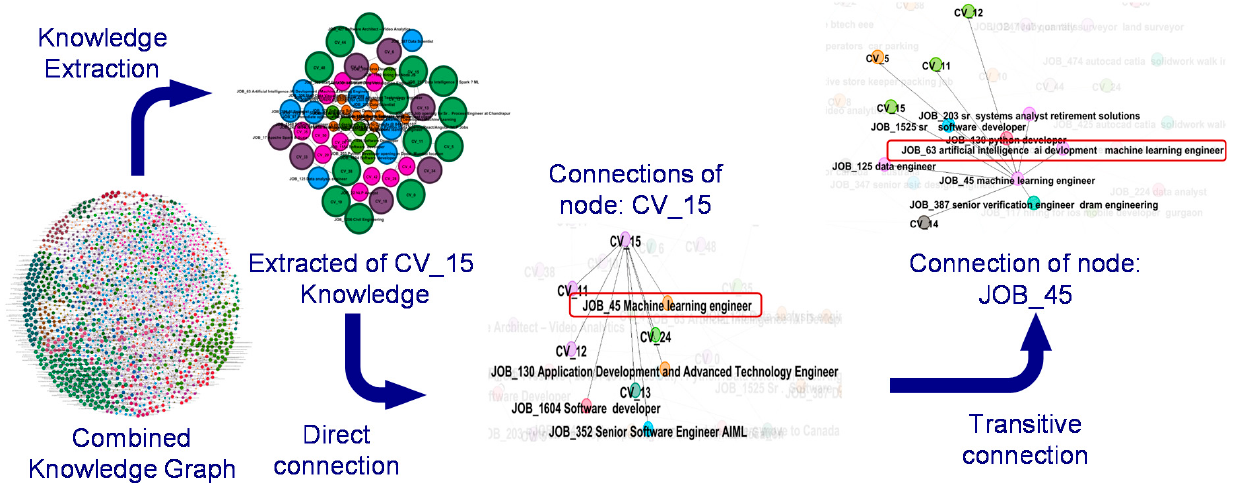
Figure 8. Direct relations between user profiles and relevant job postings. Each relation is defined based on the similarity score between the two nodes.